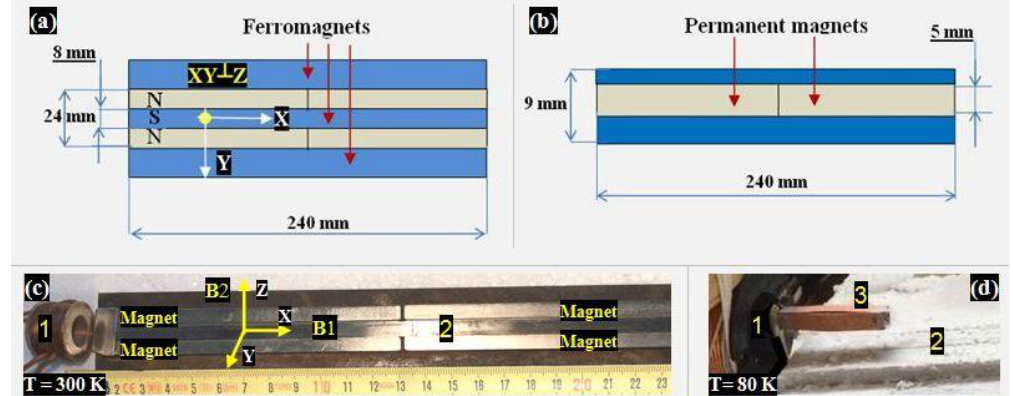
Figure 3. Noncontact acceleration setup. In ( a , b ): permanent magnet guideway (PMG)-system dimensions (as a whole, it lies on a ferromagnetic substrate); in ( c ): a top view of the mutual arrangement of the field coil (1) and the PMG-system (2) of two magnets covered with a ferromagnetic plate; in ( d ): a starting location of the high temperature superconductors (HTSC)-Sabot (3), just before the acceleration, with the directions of the levitation force (vector B2 in parallel to the Z-axis) and of the driving force (vector B1 in parallel to the X-axis), as well as along the acceleration length (X-axis).